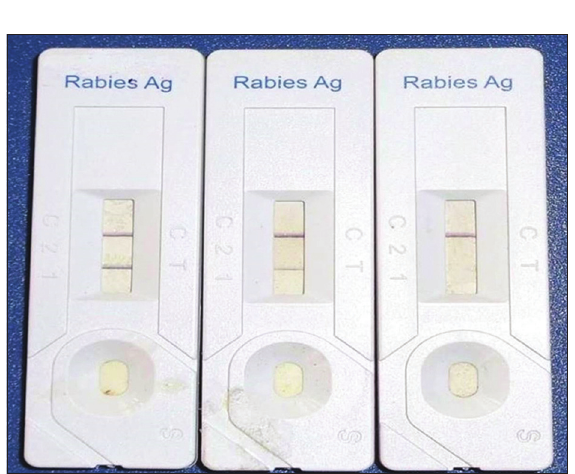
Figure-4: Rapid immunodiagnostic assay A and B are positive and C is negative.